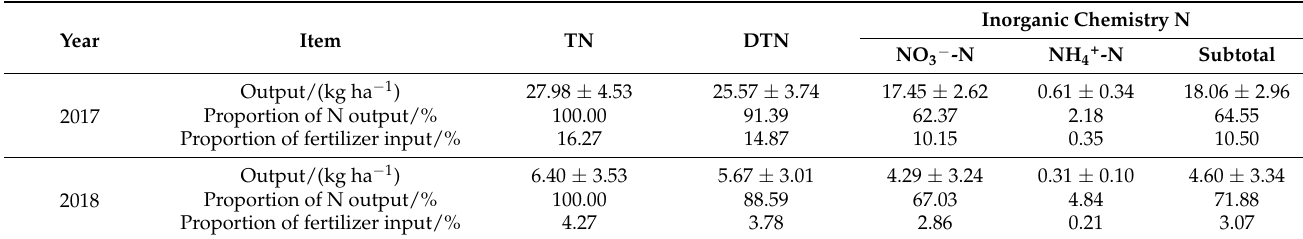
Table 3. Loss amount and rate of fertilizer N via leakage in peanut-growing